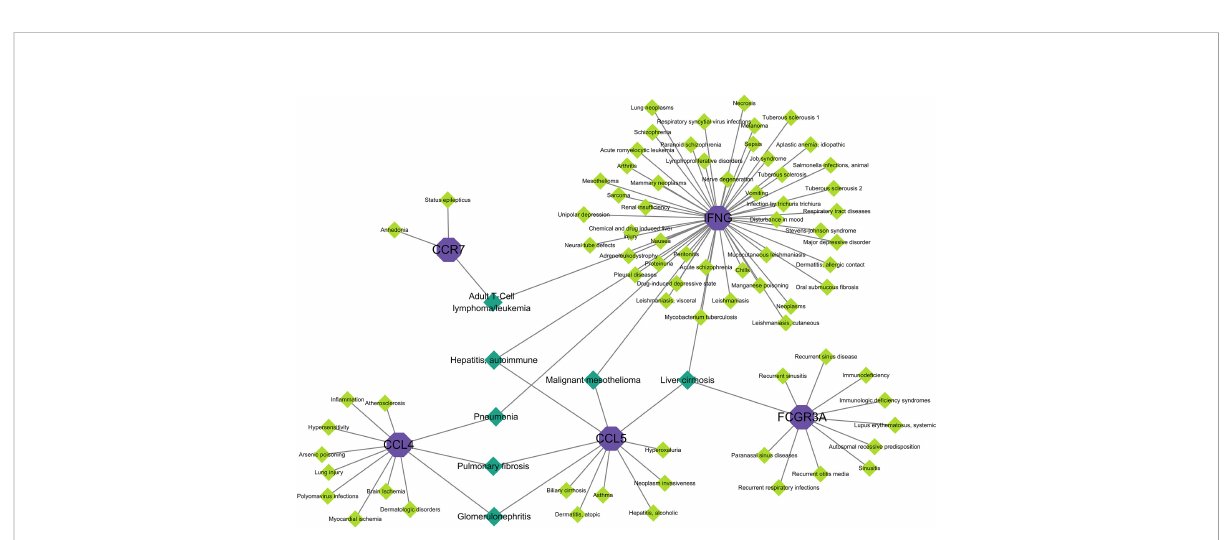
FIGURE 8 Gene – disease interaction network analysis. Purple dots in the graph indicate hub gene, green dots indicate diseases associated with hub genes, and dark green dots indicate diseases associated with multiple hub